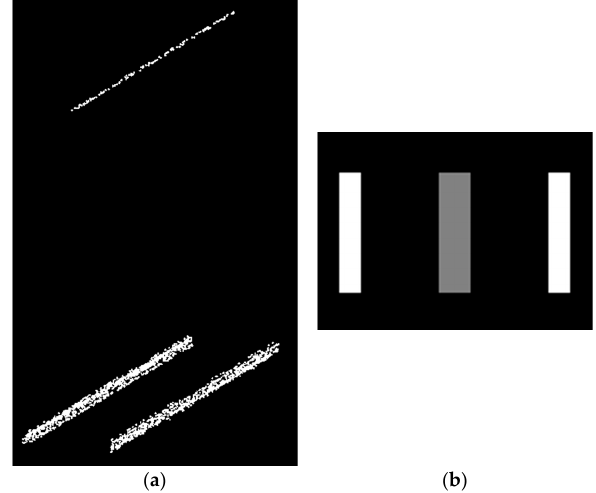
Figure 6. The template: ( a ) The template point cloud; ( b ) Its corresponding greyscale image including one meter of a pair of rail tracks and one meter of a contact cable atop in which the rail tracks are depicted in white color and the contact cable is shown in grey color